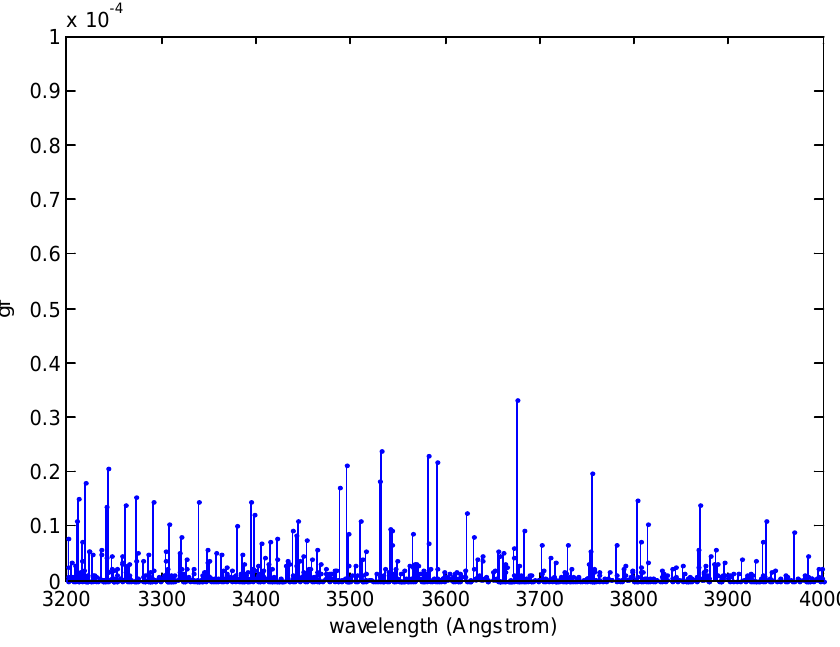
Fig.14: Emission spectrum of the second ionization of (Ho